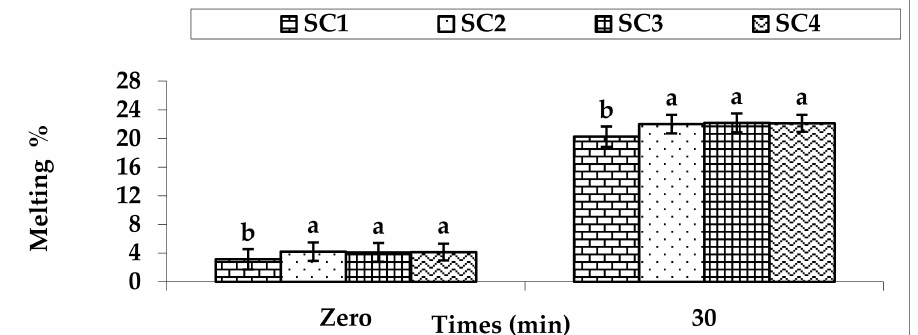
Figure 1. Melting percentage of ice cream treatments. SC1: control without artificial sugar; SC2: ice cream with stevia; SC3: ice cream with sucralose; SC4: ice cream with sorbitol; a and b : bars within the same time not sharing a common letter are significantly different ( p < 0.05).